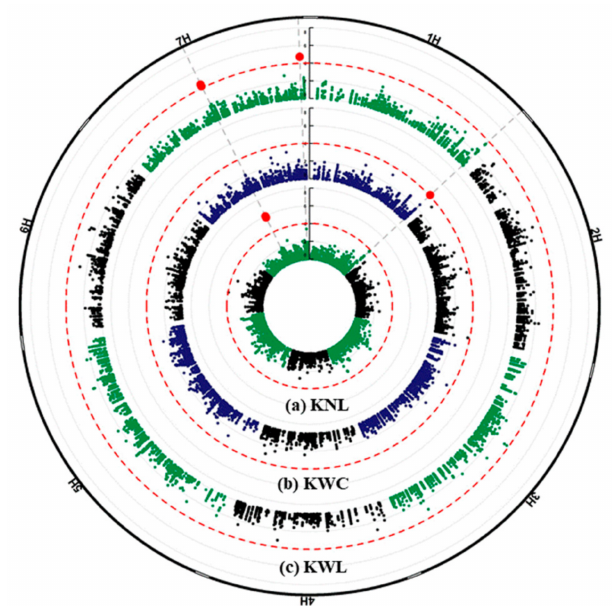
Figure 6. Circular Manhattan plots of genome-wide association scans for central (blue) and lateral (green) spikelets for ( a ) Kernel number (KN), ( b ) and ( c ) kernel weight (KW). The significance level of marker-trait associations ( − log p values) is represented by the vertical scale bar. Individual chromosomes are represented on the outer circle and separated from eachD other by white borders. − log p values ( p < 10 − 4 ) are indicated by dashed circles. Genomic regions of detected QTL on the respective chromosomes are colored in red (outer circle).